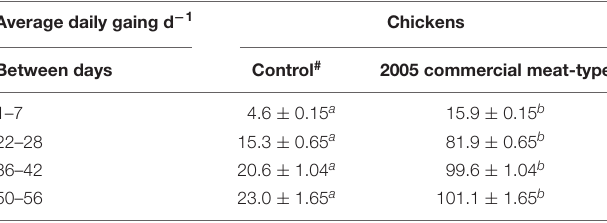
TABLE 1 | Effect of genetic selection of growth in meat-type chickens (Zuidhof et al.,